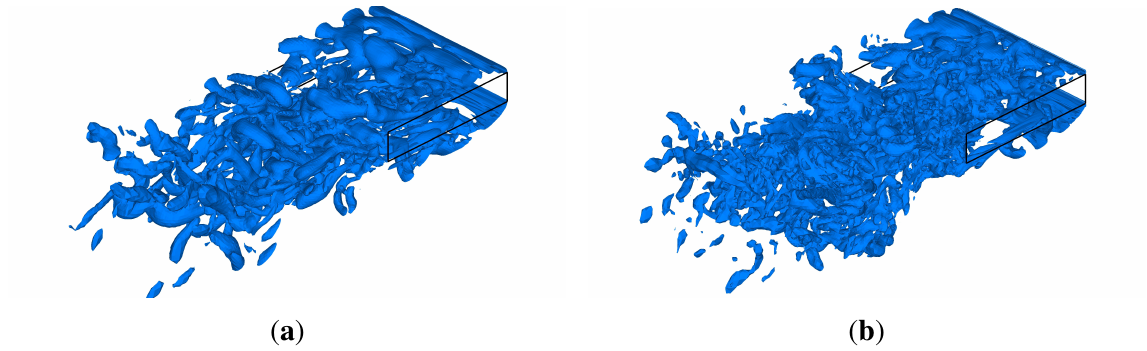
Figure 12. Q -invariant isosurface ( Q = 50) for the rectangular 5:1 cylinder: DDES-SA = 1 / 84 and ( b ) k = 1 / 256 . MD-skew with ( a ) k 4 4